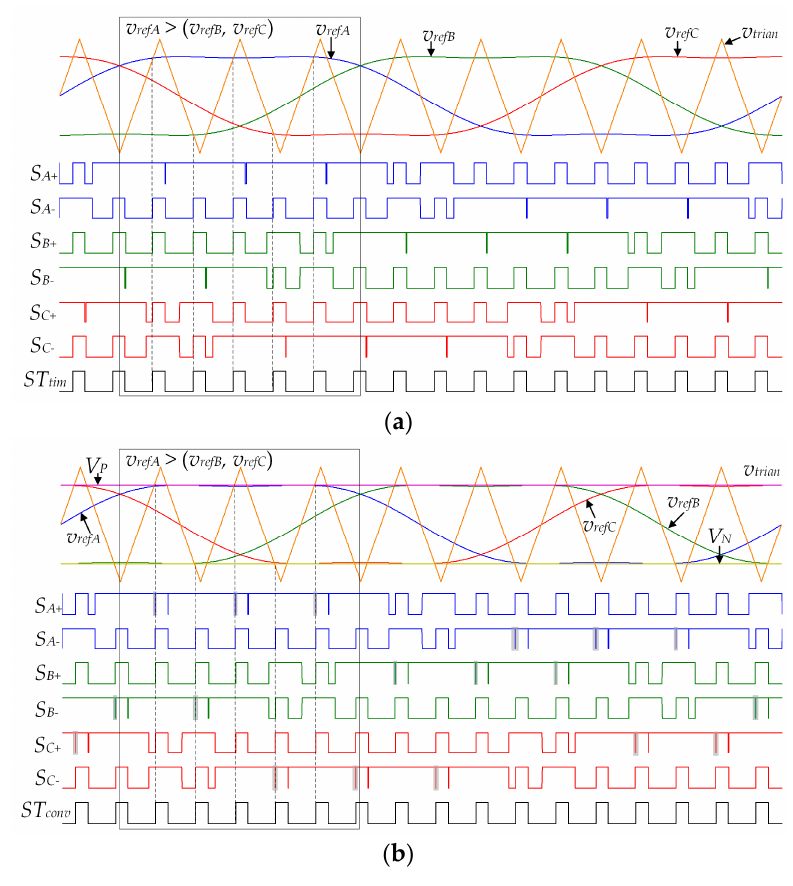
Figure 3. Waveforms of the zero-sync STS injection method ( a ) and the conventional STS injection method ( b ), with D 0 = D 0, max.